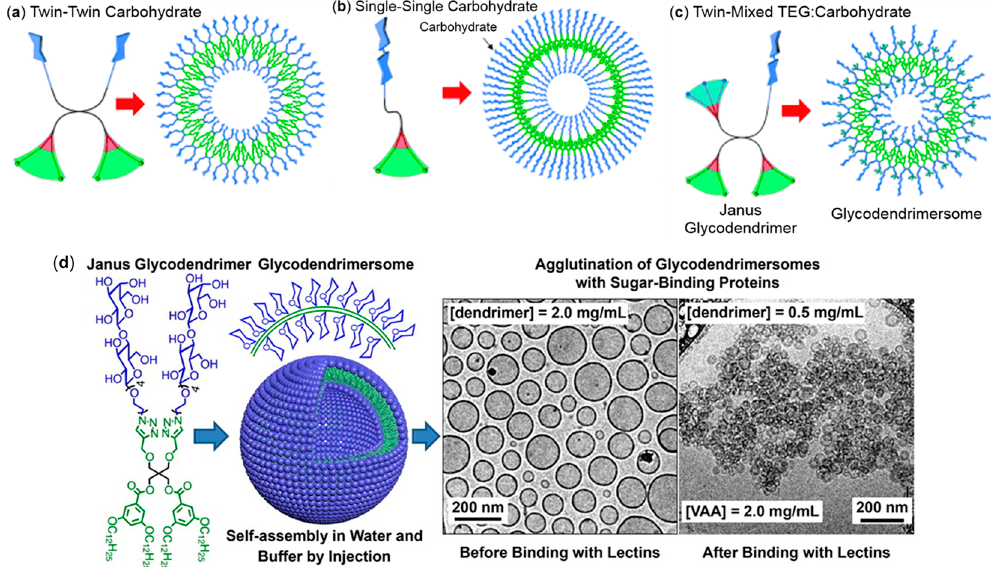
Figure 15. The different topologies of amphiphilic Janus glycodendrimers and the structure of the resulting multivalent GDSs (color code: hydrophilic blue, hydrophobic green, aromatic red) [78]: ( a ) twin–twin carbohydrates; ( b ) single–single carbohydrate; and ( c ) twin–mixed TEG:carbohydrate. ( d ) From left to right: Structure of JGD (3,5)12G1-PE-TRZ-4EOLac2, scheme of its self-assembly as GDSs in aqueous solution, cryo-TEM image of GDSs at JGD concentration of 2 mg/mL, cryo-TEM image of agglutination of GDSs at JGD concentration of 0.5 mg/mL in the presence of toxic mistletoe lectin Viscum album agglutinin (VAA) at 2 mg/mL [72]. Copyright Wiley-VCH, adapted from Angewandte Chemie International Edition 2014 [78]; Copyright American Chemical Society, reprinted from Journal of the American Chemical Society 2013